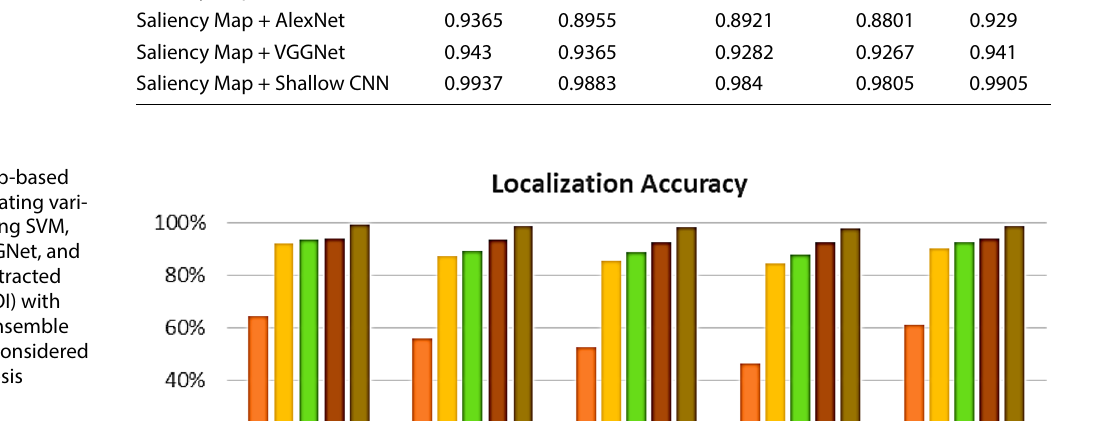
Table 4 The Experimental Analysis of Localization Accuracy Evaluated on Five Public Datasets